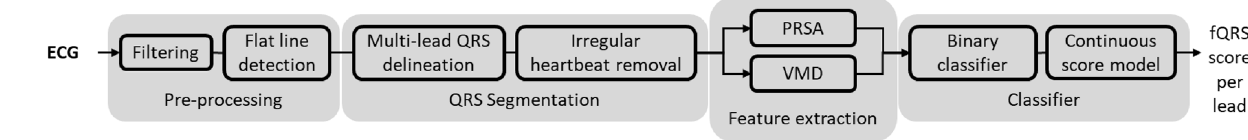
Figure 1. Block diagram of the fQRS scoring algorithm per